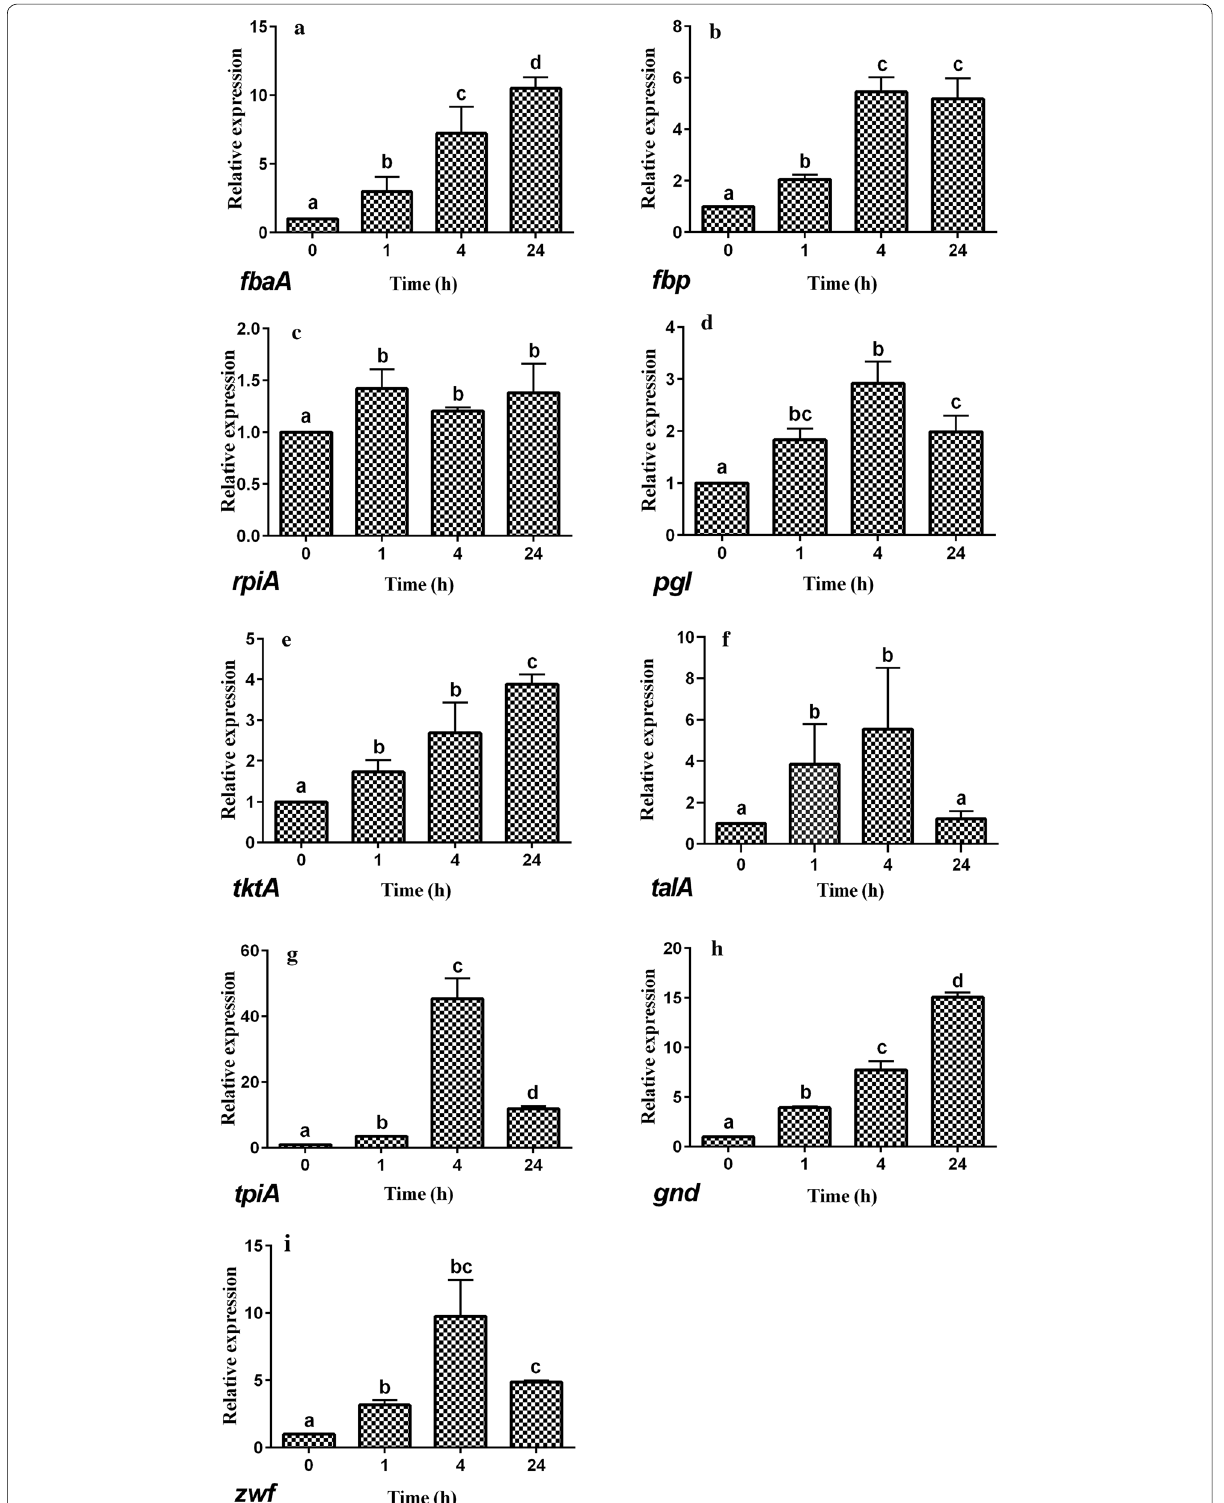
Fig. 4 Relative expression of genes in hexose monophosphate pathway of E. coli CFT073 exposed to dithiocyano-methane. Different small letters indicate significant differences in exposed group among different times (P < 0.05), and bars represent standard deviations of the